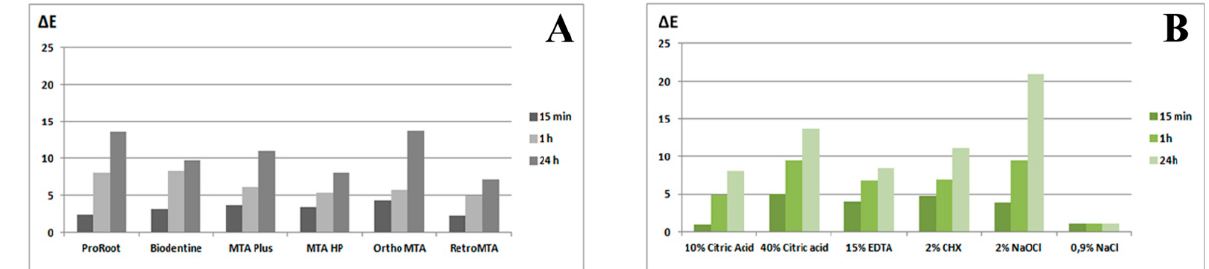
Figure 5. Average color variation Δ E over time. ( a ) independent of the irrigant used; ( b ) independent of the material used. Upon immersion of the materials in both 10% and 40% CA, the type of staining was the least predictable (Table 2). Naked-eye observation revealed that the CSCs either did not change color (scale 0) or became whiter, such as with MTA Repair HP (scale 2). In no case did the CSCs become darker. After storage in CA (both 10% and 40%) for 24 h, Biodentine, Retro MTA, and MTA Repair HP appeared corroded on the surface (scale b) for both 10% and 40% solutions (Figure 2). Table 2. Evaluation of the changes in the color and structure of CSC materials upon contact with different irrigation solutions. Material